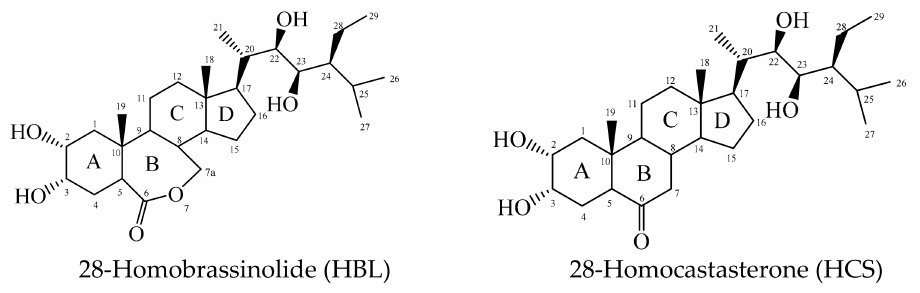
Figure 1. Chemical structure of